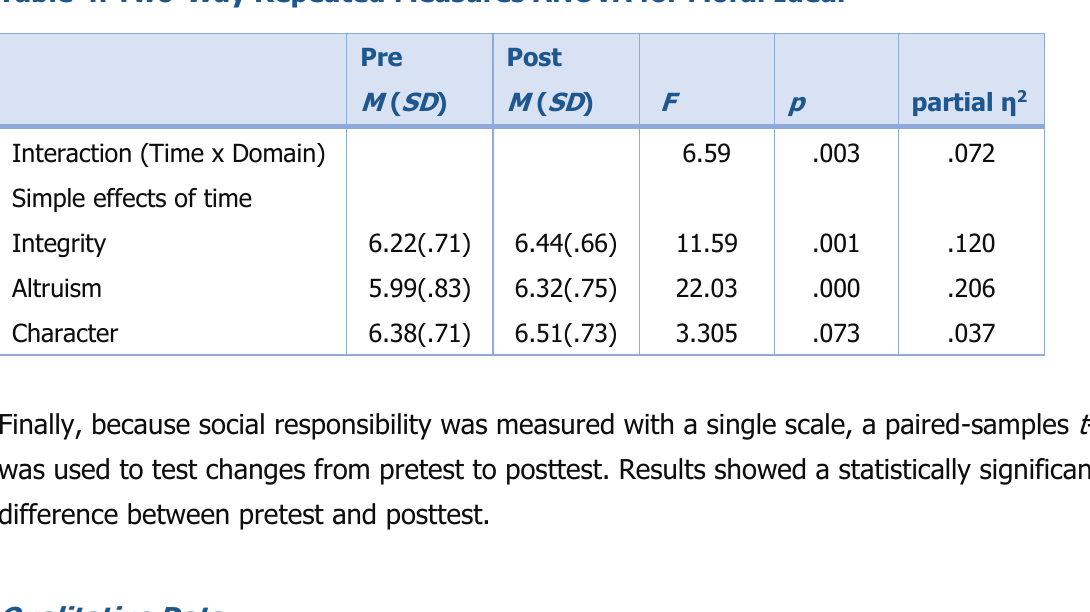
Table 4. Two-Way Repeated Measures ANOVA for Moral Ideal